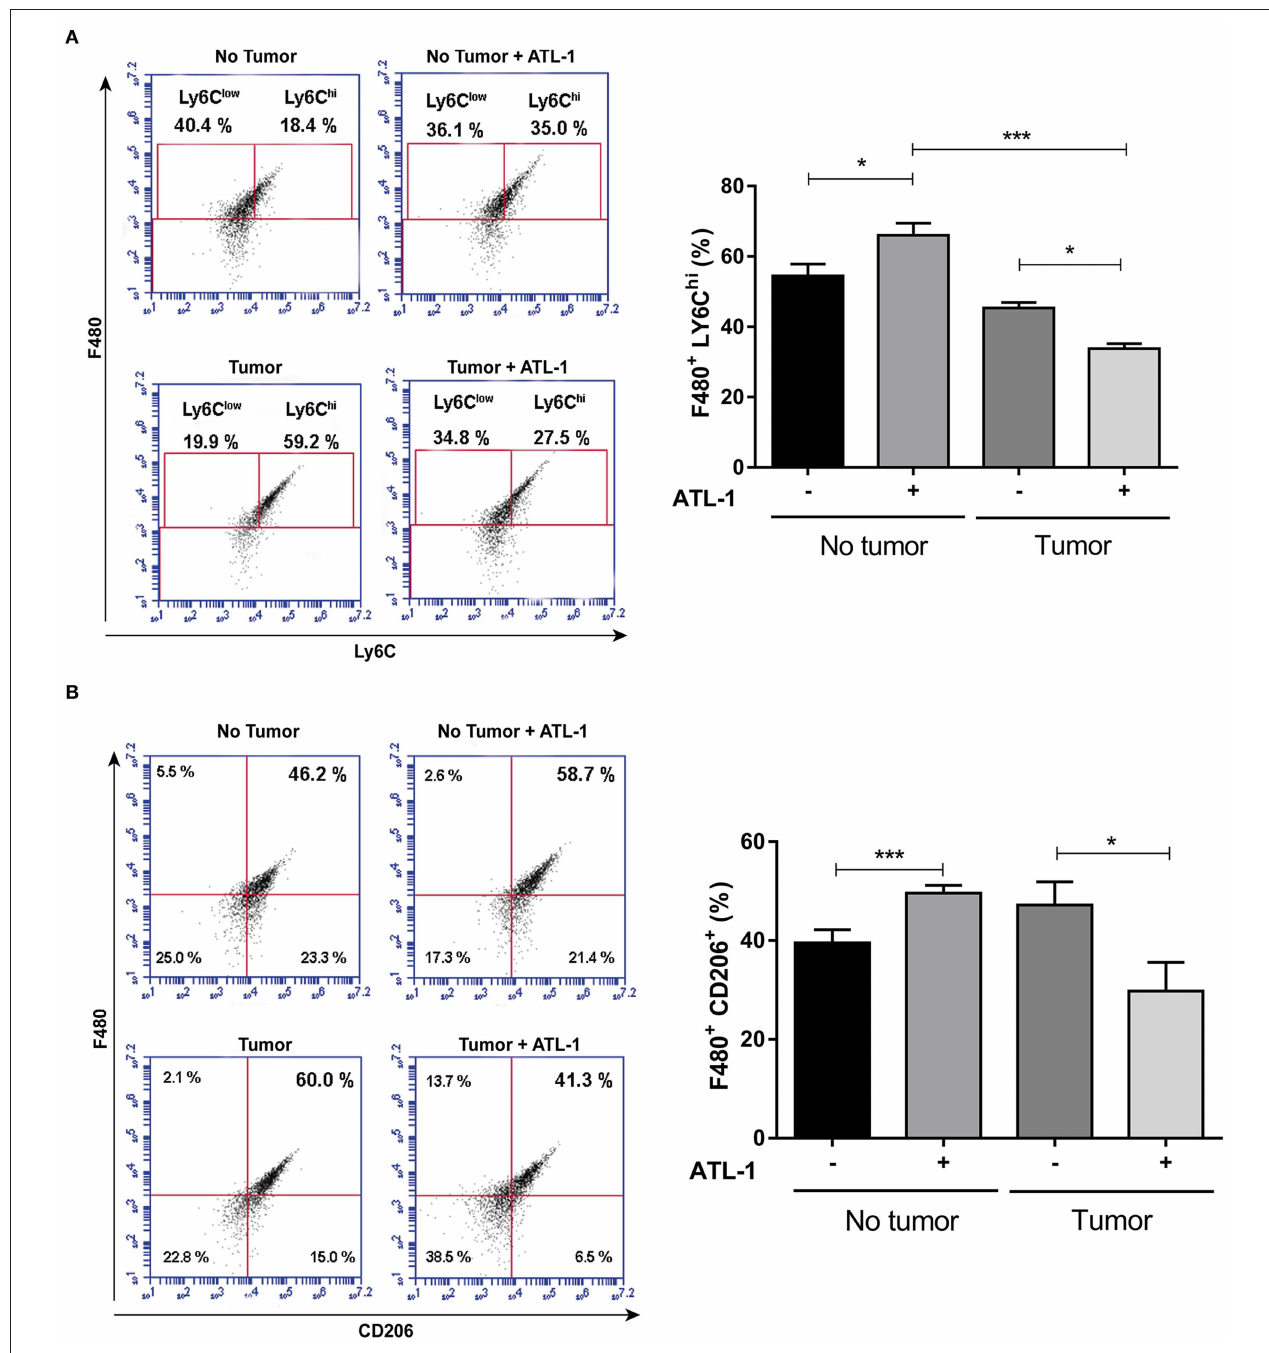
FIGURE 5 | ATL-1 has a selective effect on monocytes from tumor-bearing mice. C57/BL6 mice were inoculated or not with B16/F10 tumor cells. After 14 days, animals with or without tumor, were anesthetized and blood was withdrawn by cardiac puncture. Monocytes were isolated from the blood, seeded in 96-wells plate, treated or not with ATL-1 (10nM) for 3 days and analyzed by flow cytometry. (A) F480/LY6C hi population 3 days after ATL-1 treatment ( n = 6); (B) F480/CD206 population 3 days after ATL-1 treatment ( n = 6). Data are expressed as mean ± SEM. * p < 0.05 ; *** p < 0.001 by ANOVA test, followed by Bonferroni test.